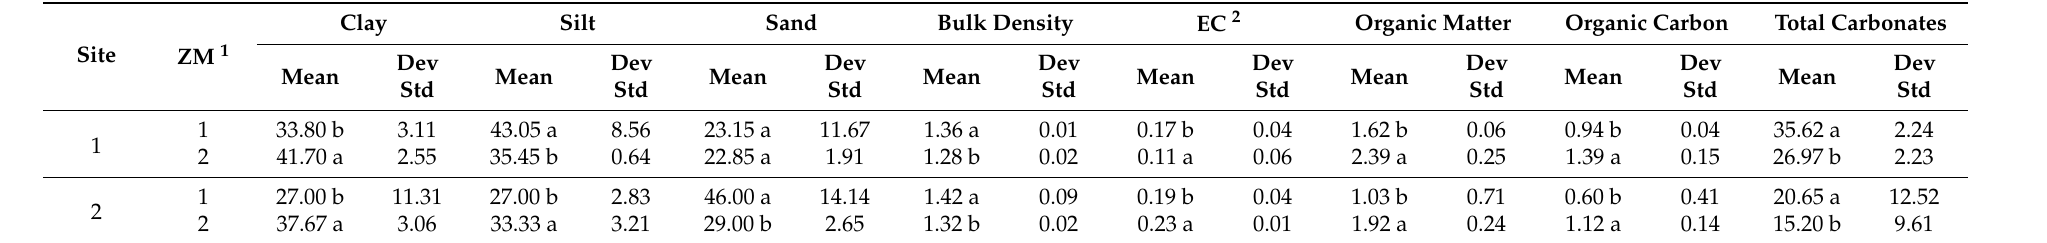
Organic Matter Organic Carbon Total Carbonates